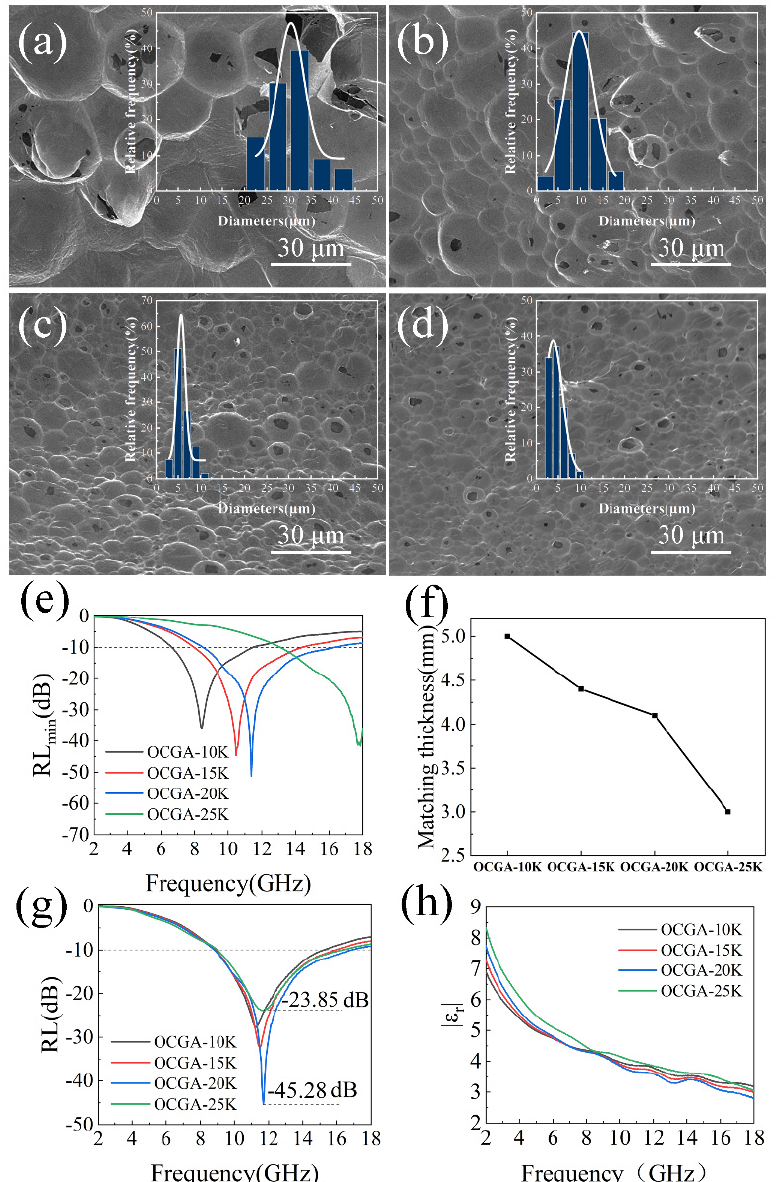
Figure 6. Characterization of OCGA with different cell diameters. SEM images of ( a ) OCGA-10K, ( b ) OCGA-15K, ( c ) OCGA-20K and ( d ) OCGA-25K, showing an average diameter of about 30 µ m, 9 µ m, 6 µ m and 4.5 µ m, respectively. ( e ) RL min of the OCGAs, reaching − 35.89 dB, − 44.65 dB, − 51.22 dB and − 41.61 dB, respectively. ( f ) Matching thickness of OCGA at RL min . ( g ) RL of OCGA at the matching thickness of 4 mm. ( h ) Modulus of the complex permittivity of OCGA. The compressive strength of graphene aerogels is also obviously improved when the cell structure is introduced. The compression performance of GA and OCGAs with different cell sizes was tested. The results show that compression strength of GA without cell structure is 3.6 kPa. When the cell structure exists, the compressive strength of OCGAs increases obviously, and its maximum value reaches 9.5 kPa of OCGA-20K with a 167% increase (Figure 7a). Based on this, the OCGA-20K can withstand a 1.6 × 10 4 times heavier weight than its own mass. To visualize the increase of compressive strength,